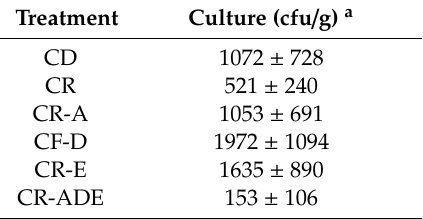
Table 1. Shedding of Mycobacterium avium subsp. paratuberculosis in feces of calves on day 7 1